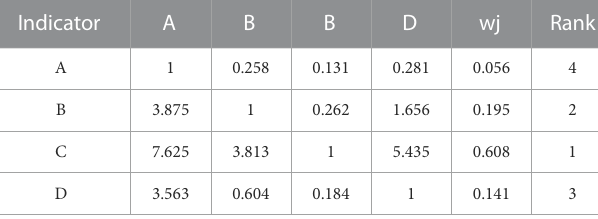
TABLE 15 Pairwise comparison matrix of criterion layer